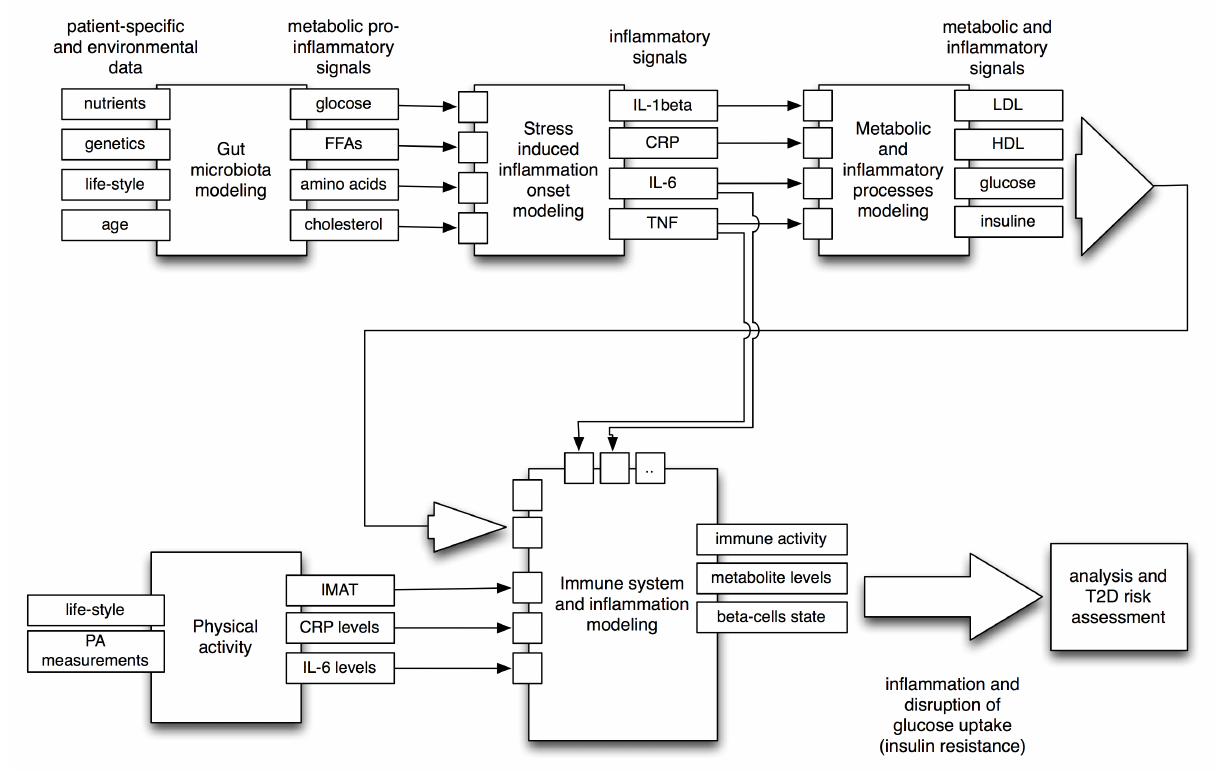
Figure 5. A simplified systemic view of the models to be developed within MISSION-T2D and the interdependencies between them. Input-output relationships among modules of these models are depicted. Feedback (eg, IL-6 from the immune system to the stress-induced model) is not shown for